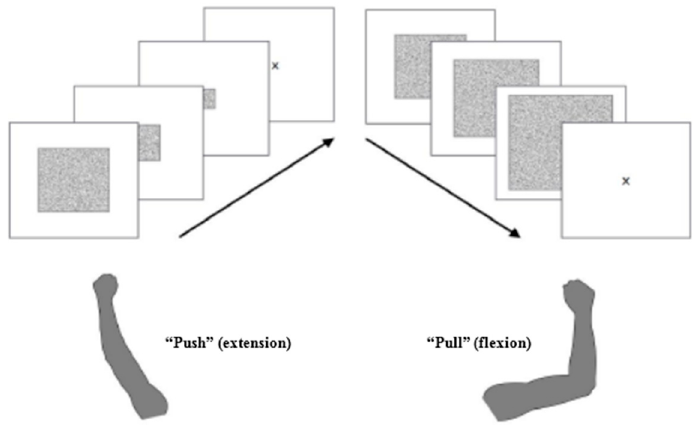
Figure 1. Participants were instructed to either “pull” or “push” food pictures shown on a computer screen based on the presented picture format (landscape vs. portrait format) by moving the computer mouse towards or away from themselves. “Pulling” a picture (flexion of the forearm) made it larger until it filled almost the complete screen and then disappeared, while “pushing” a food picture (forearm extension) caused the picture to shrink to a dot and disappear from the screen (for more details see main text).